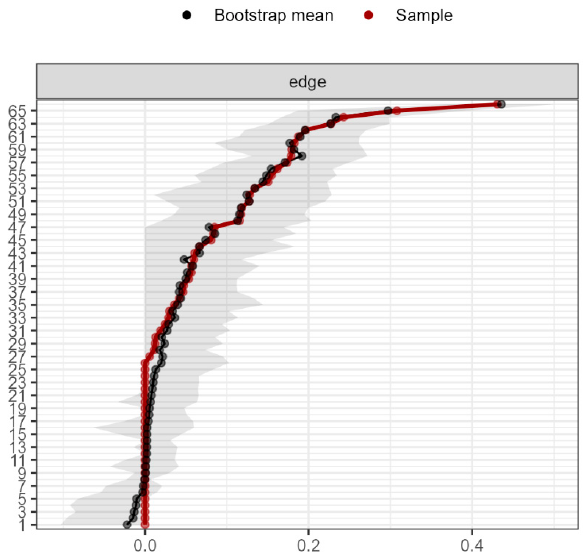
Figure 4. Precision in the estimation of the edges (red line, in the order of the highest to the lowest), and the 95% confidence interval of the estimates (gray line) for the network in the ‘month’ moment, estimated with the non-parametric bootstrap